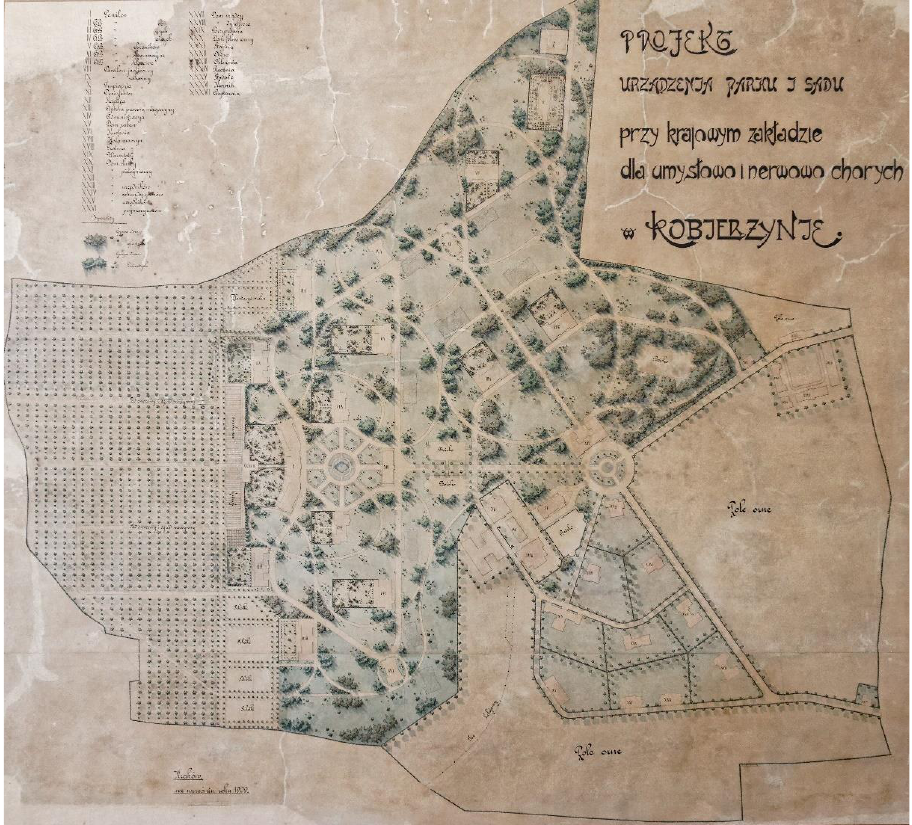
Figure 3. A plan of the establishment of a park and orchard around the National Institute for the Nervous and Mentally Ill in Kobierzyn, Kraków, 1909, drawing by Wiktor Żochowski ; source: the archive of the Babiński Clinical Hospital .